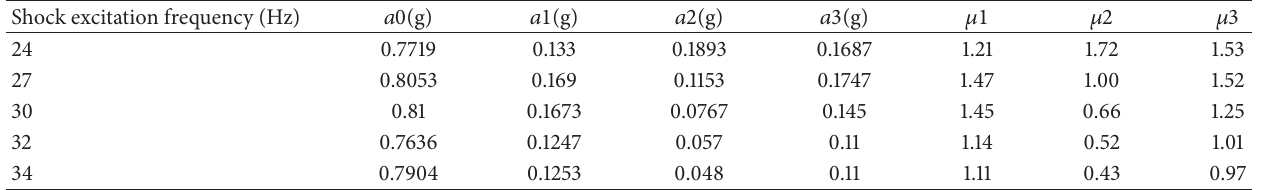
Table 10: Extreme and enhanced coefficient of acceleration response (0.75 g).